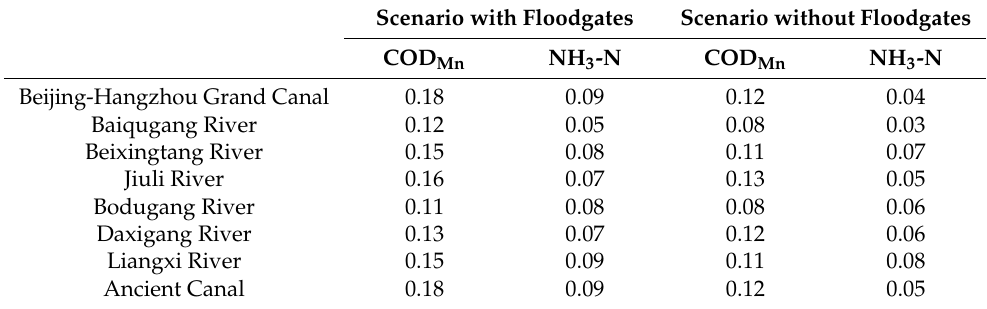
Table 1. Degradation coefficient for the quality of pollution in the river network (unit: d − 1 ). Scenario with